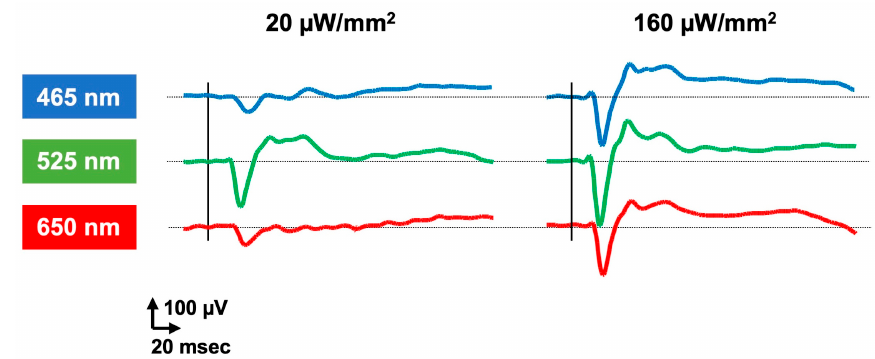
Figure 4. Recordings of visual-evoked potential (VEP) in ComV1-transduced RCS rat. Visual responses to stimuli of broad wavelength ranges within visible light spectrum were demonstrated.